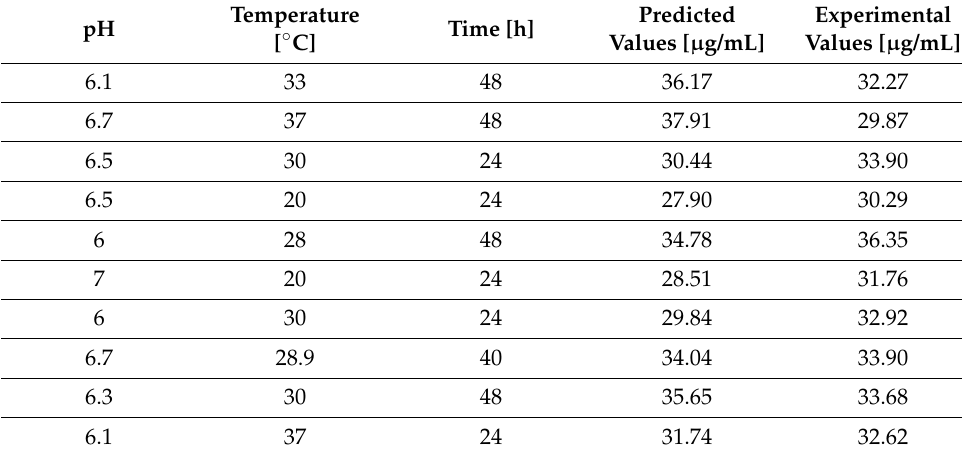
Table 5. Experimental variants used for the validation of the